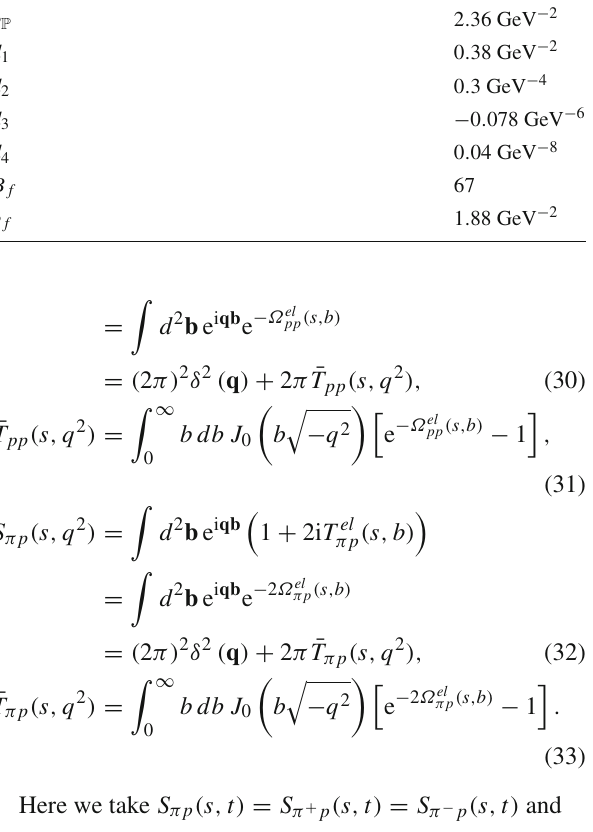
Table 2 Parameters for pion–proton elastic scattering amplitude Parameter Value B P 26 .